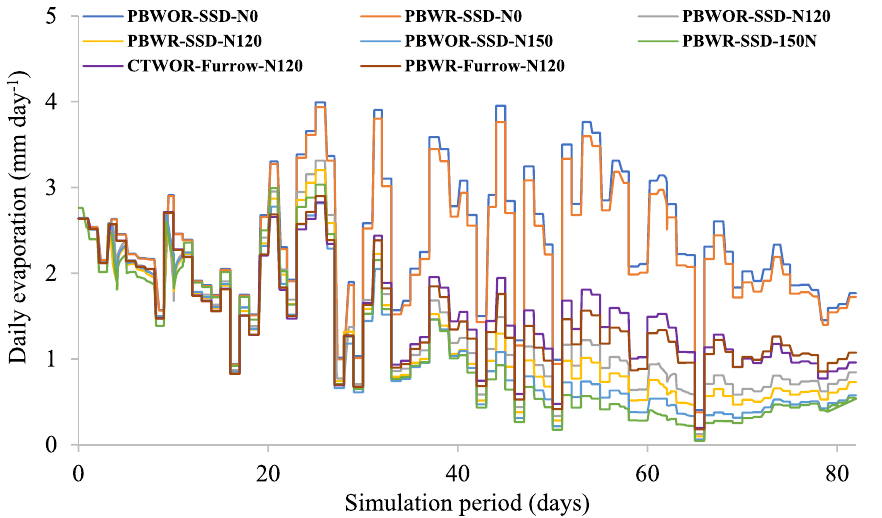
Figure 3. Daily evaporation (mm day −1 ) pattern during the simulation period in maize under different tillage, residue, N and irrigation treatments. For treatment detail please see Table 4.